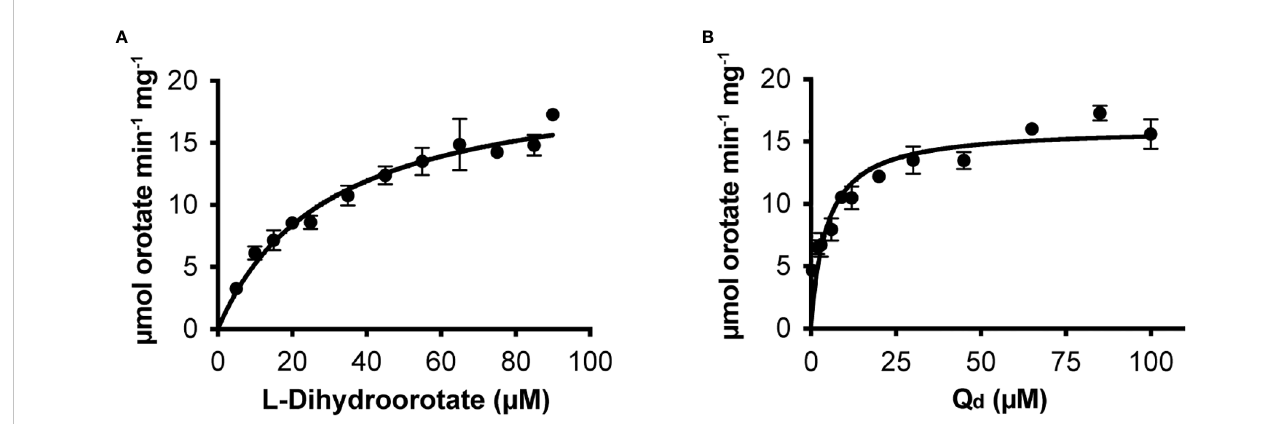
FIGURE 2 Steady state kinetics of puri fi ed recombinant OsDHODH. (A) Saturation curve for L-dihydroorotate. (B) Saturation curve for decylubiqinone, Q d .